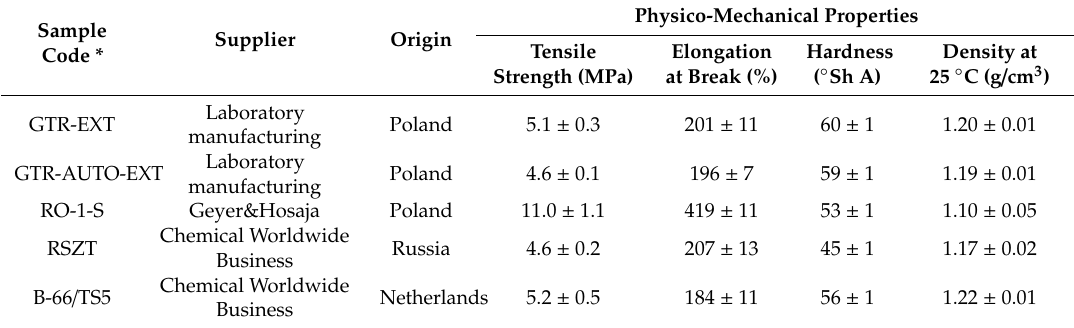
Table 9. A comparison between commercial reclaimed rubbers and reclaimed GTR produced in the laboratory scale (throughput: 2.5 kg /